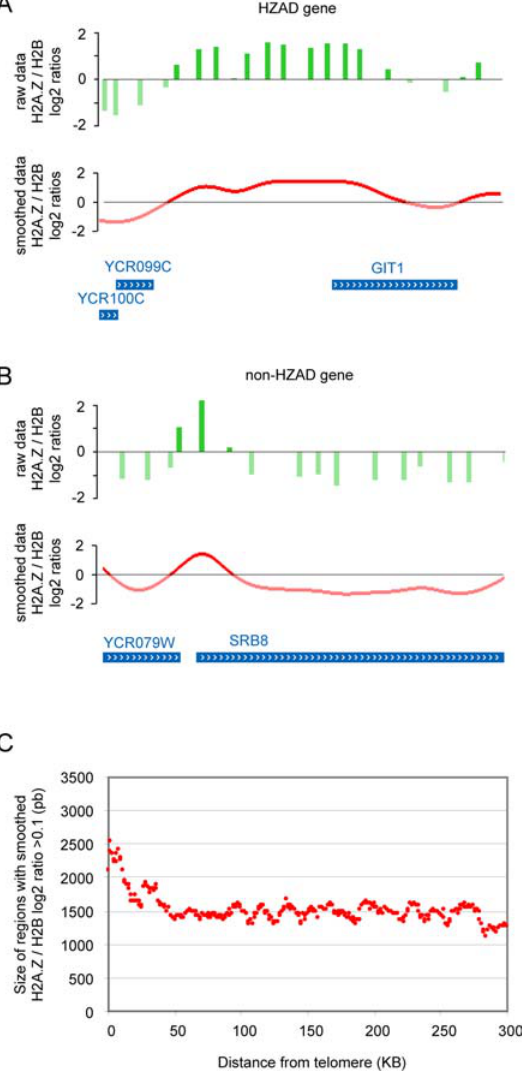
Figure 5. H2A.Z Is Unusually Localized in HZAD Genes (A) The raw (green) and smoothed (red) H2A.Z/H2B log 2 ratios, as determined by our microarray experiment, are shown across a 5-KB region around the GIT1 genes. The genes present in that region are shown in blue. (B) Same as (A) but for a 5-KB region around the SRB8 gene. (C) H2A.Z covers wider regions near telomeres. The size of the regions covered by H2A.Z (as determined by distance between the coordinates where the smoothed H2A.Z/H2B log 2 ratio reaches ‘‘ 0.1 ’’ ) is plotted against the distance to telomeres. A moving average (window ¼ 10 KB) was applied to the data. DOI: